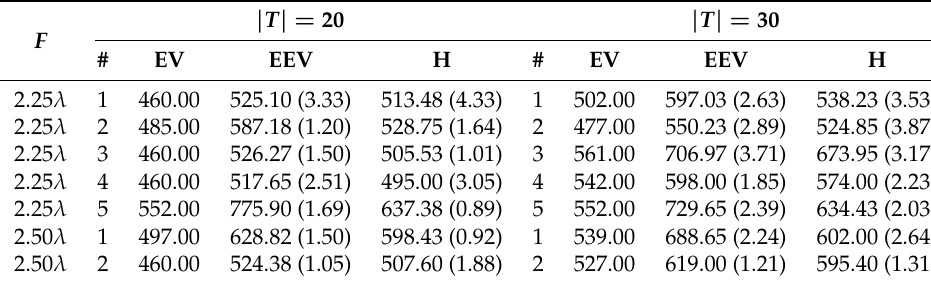
Table 4. Results for m = 3